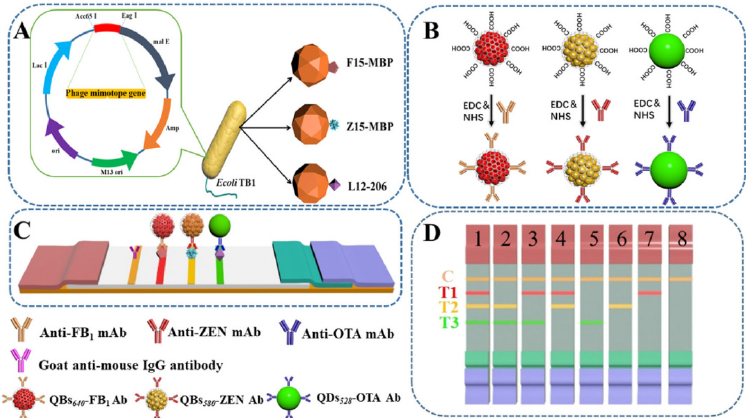
Figure 6. Scheme of the biosynthetic mycotoxin conjugate mimetics for multiplex mycotoxin immunochromatographic assays. ( A ) Biological expression strategy of peptide-MBP fusion protein; ( B ) fabrication process of the prepared QDs/QBs-mAb probes; ( C ) schematic illustration of the tricolor mICA; ( D ) schematic illustration for the interpretation of test results. (1) negative; (2) FB1; (3) ZEN; (4) OTA; (5) FB1 and ZEN; (6) FB1 and OTA; (7) ZEN and OTA; and (8) FB1, ZEN, and OTA. Reproduced with permission from [90]. Copyright (2020) American Chemical Society.